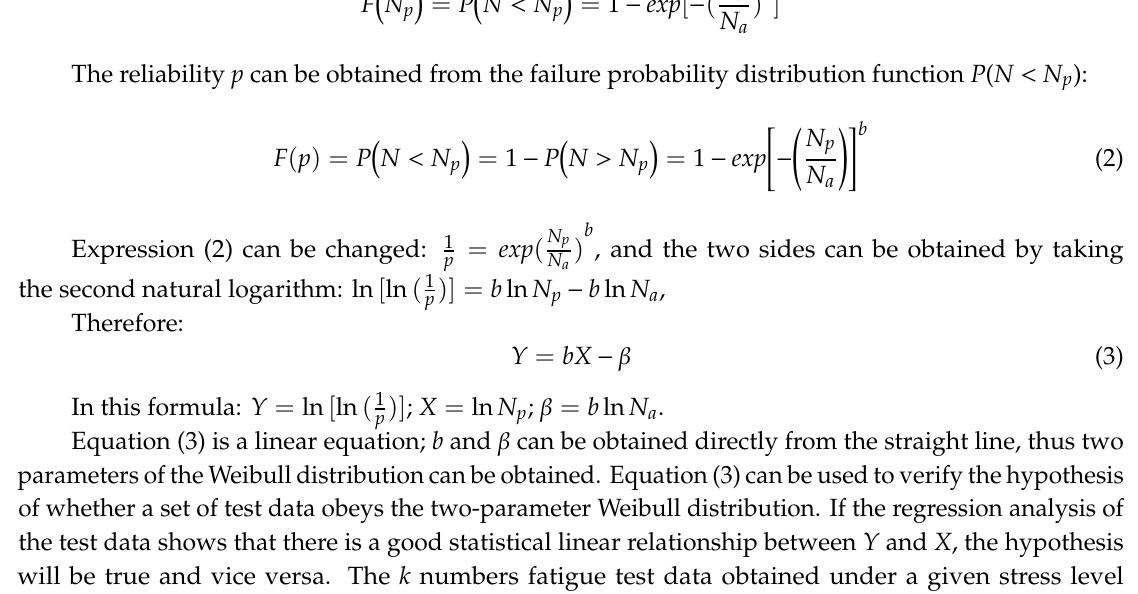
Table 10. The results of regression analysis of fatigue test according to Equation (3). Stress Level S max =0.60 Stress Level S max =0.70